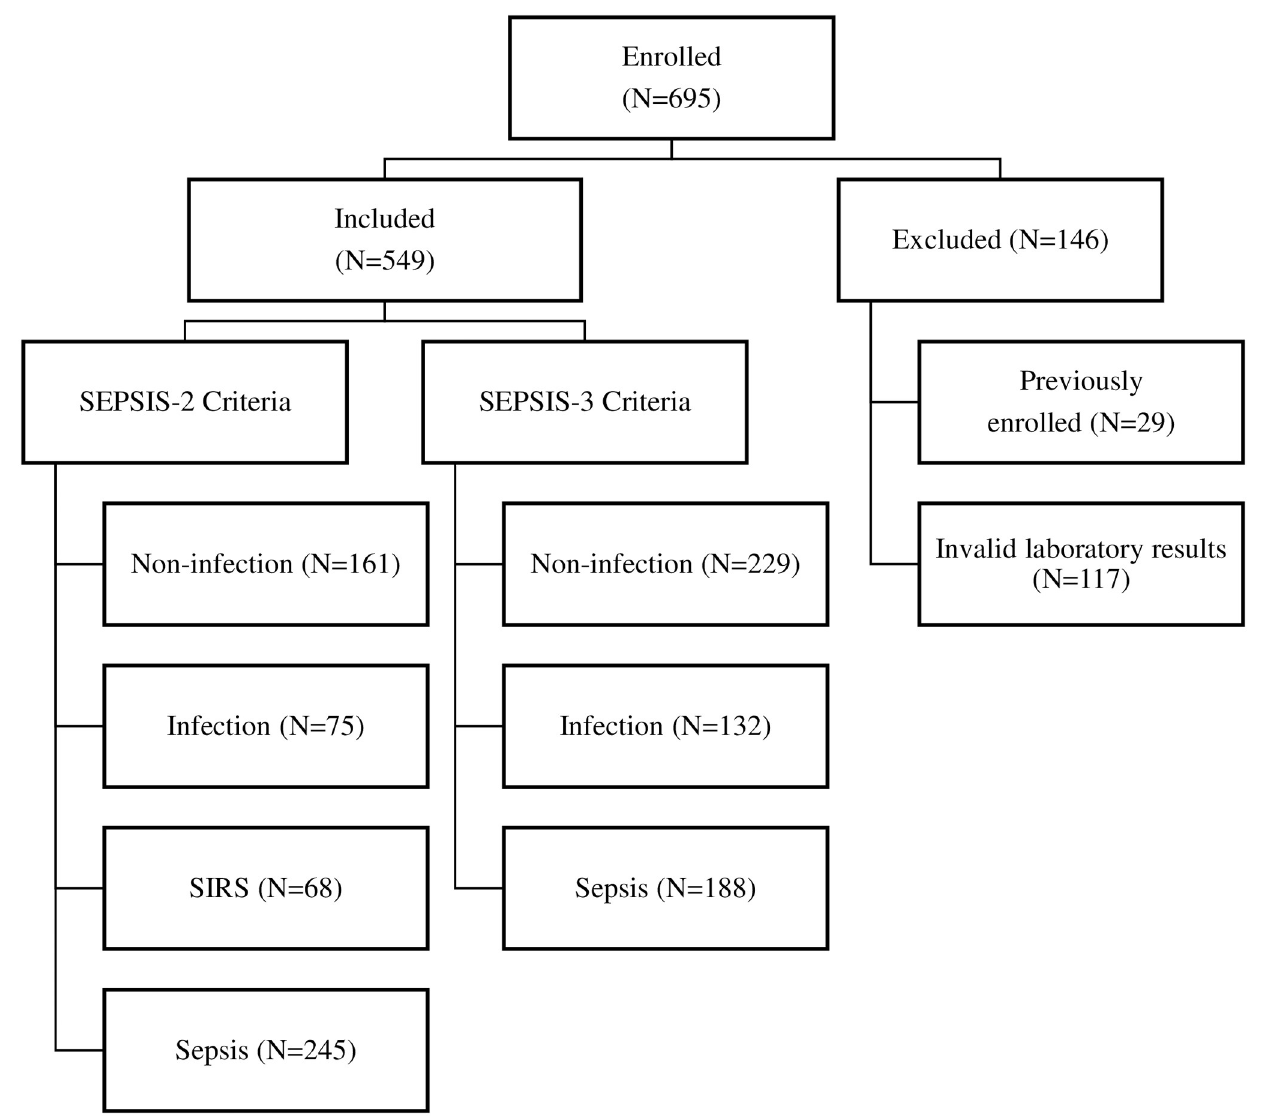
Fig 1. Flow of the